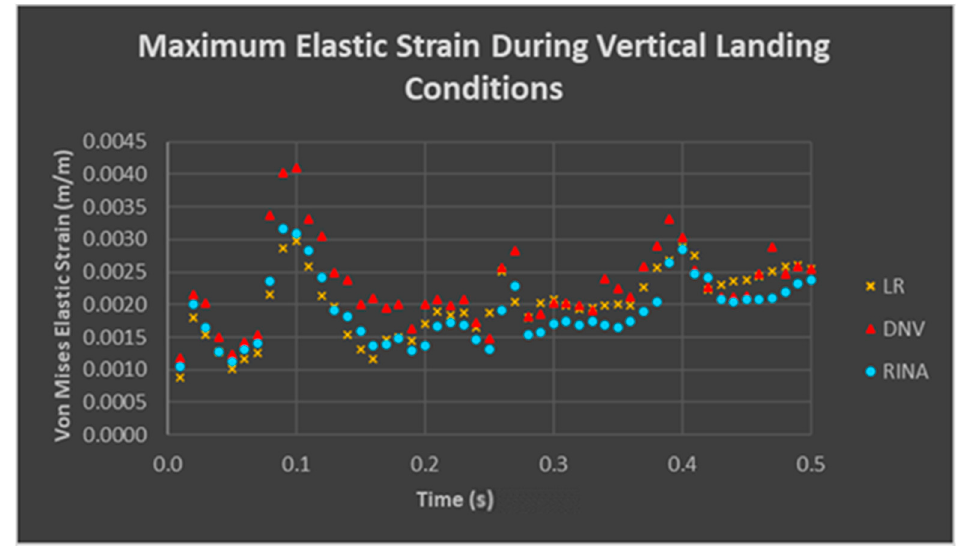
Figure 11. Maximum elastic strain of the deck plate under the vertical landing condition.